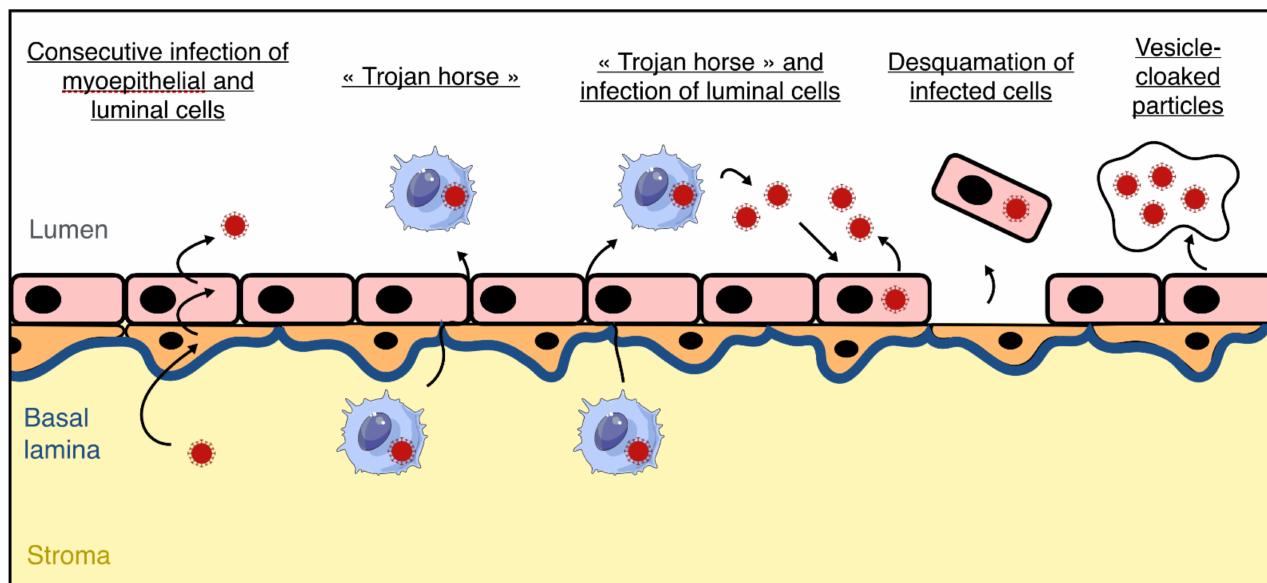
Figure 3. Hypothetical mechanisms of blood–milk barrier crossing by Zika Virus (ZIKV). In order to explain the presence of ZIKV particles in breast milk of infected mothers, several mechanisms could occur. Free viral particles (dark red) present in the bloodstream could sequentially infect myoepithelial cells (orange) and luminal cells (pink), resulting in the production of free viral particles in breast milk. Infected immune cells from the bloodstream (blue) could cross the epithelial barrier via the paracellular route by the « Trojan horse » mechanism, resulting in the presence of infected cells in breast milk that could produce viral particles. The viral particles produced could productively infect the luminal cells of the epithelium resulting in the presence of both cell-free and cell-associated ZIKV in breast milk. Infected epithelial cells could also be found in breast milk after being split off from the epithelium. Finally, it cannot be excluded that vesicles containing multiple virions could be produced by the mammary